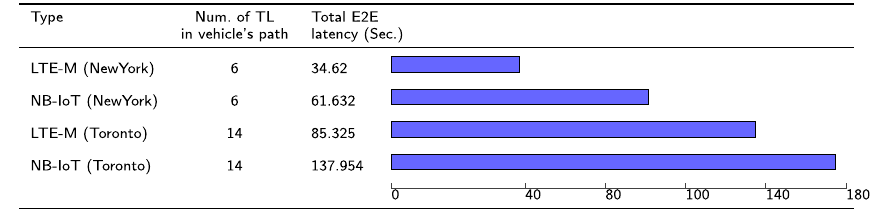
Table 5 Emergency vehicle scenario in New york city and